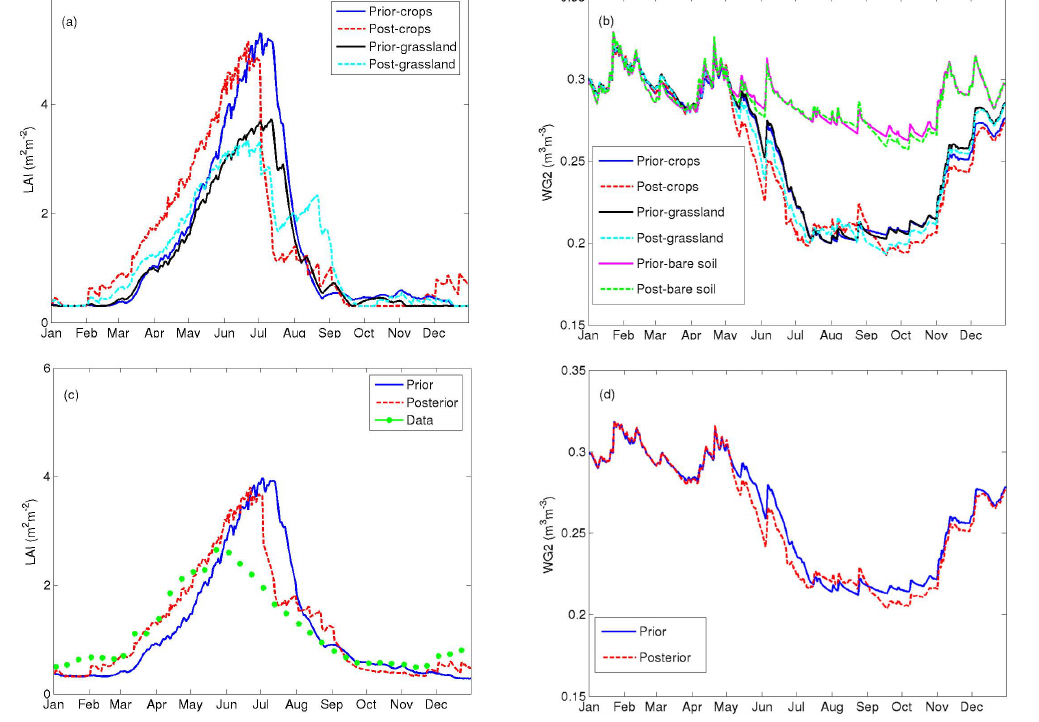
Fig. 5. Time series of prior and posterior LAI in m 2 m − 2 (left panels) and volumetric root-zone soil moisture (right panels) per patches (top panels) and per grid cell (bottom panels) at a location (43.35 ◦ N, 1.30 ◦ E) for the year 2009. The majority of patches are cropland (48%), grassland (19%) and bare soil (14%). The LAI satellite data gathered at this location are depicted by